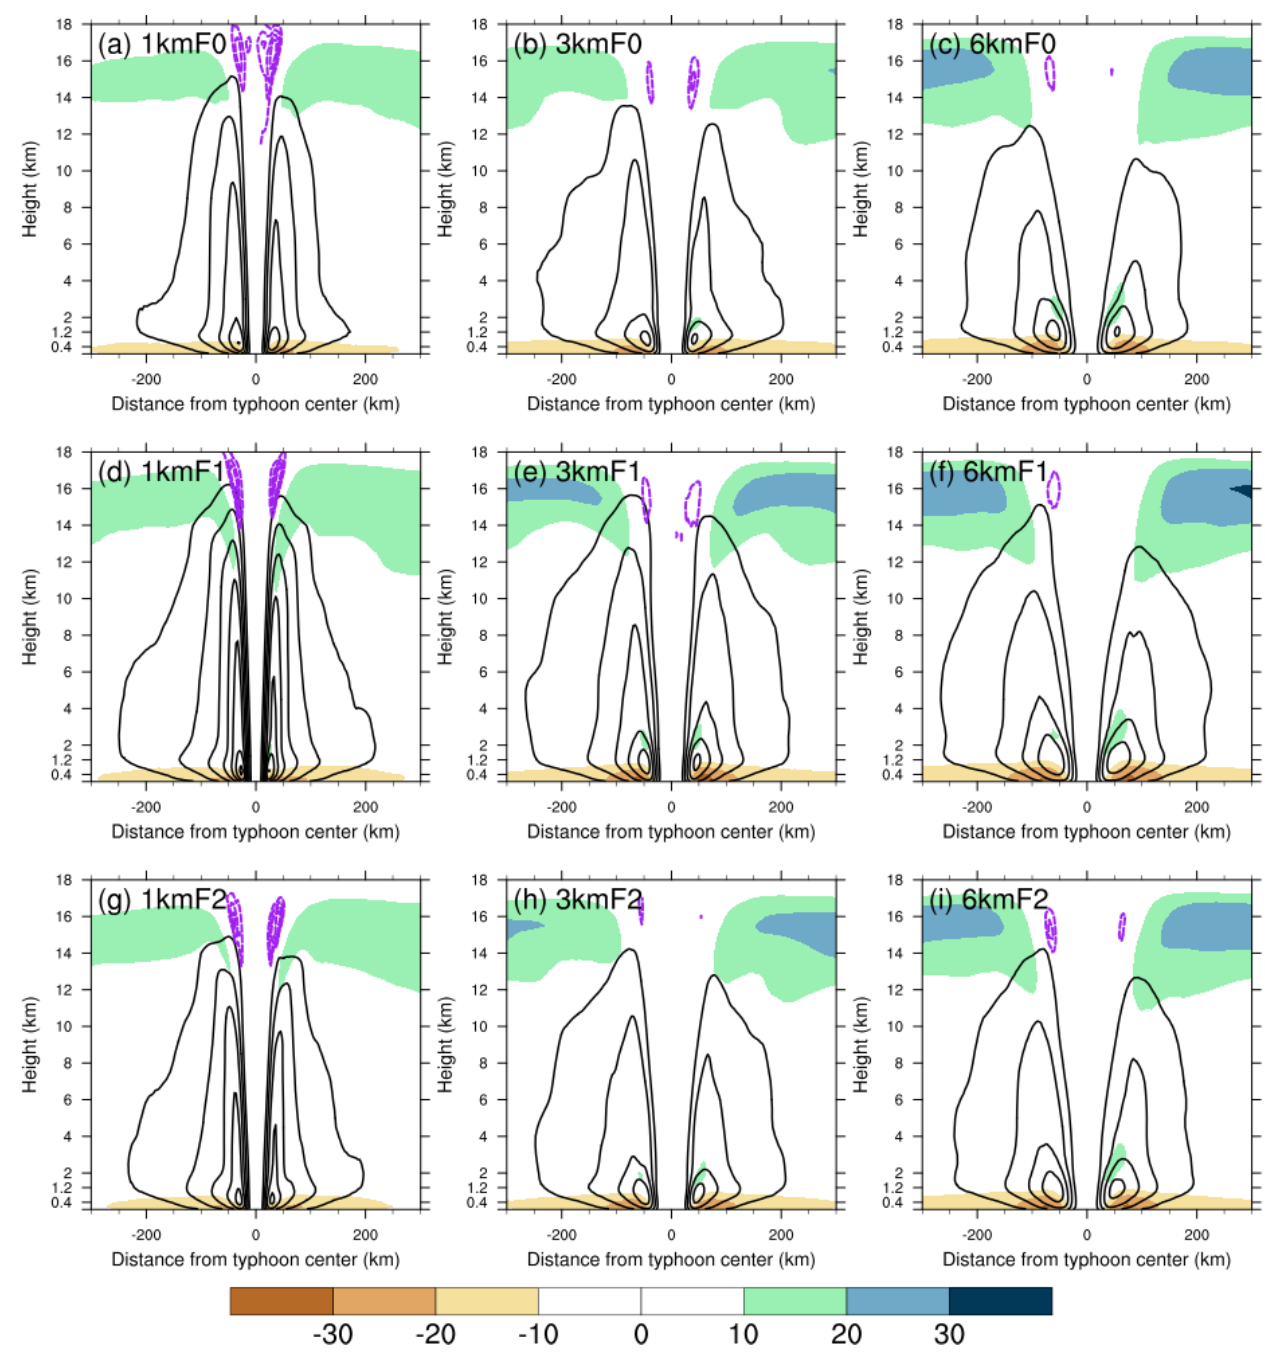
Figure 10. Radius–height cross sections of tangential wind (contours; ms − 1 ) superposed on radial wind (color shaded; ms − 1 ) for experi- ments (a) 1kmF0, (b) 3kmF0, (c) 6kmF0, (d) 1kmF1, (e) 3kmF1, (f) 6kmF1, (g) 1kmF2, (h) 3kmF2, and (i) 6kmF2. The tangential winds are contoured every 10ms − 1 starting from 30ms − 1 . Positive values of radial wind indicate inflow. The upper-level radial inflows (purple dashed contours; ms − 1 ) are also superimposed and are contoured every 0.5ms − 1 starting from − 0 . 5ms − 1 . All fields are time averaged between 18:00UTC on 7 November 2013 and 00:00UTC on 8 November 2013. Positive and negative distances represent the right (northern) and left (southern) semicircles as in Fig.